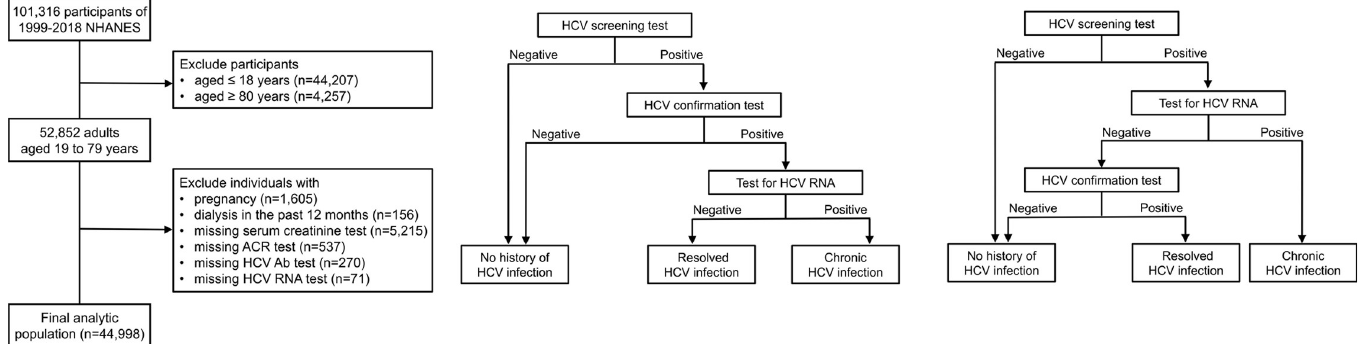
Fig 1. (A) Flow diagram of the study population selection. (B) Hepatitis C virus (HCV) testing algorithm in 2012 and earlier years. (C) HCV testing algorithm after 2013.